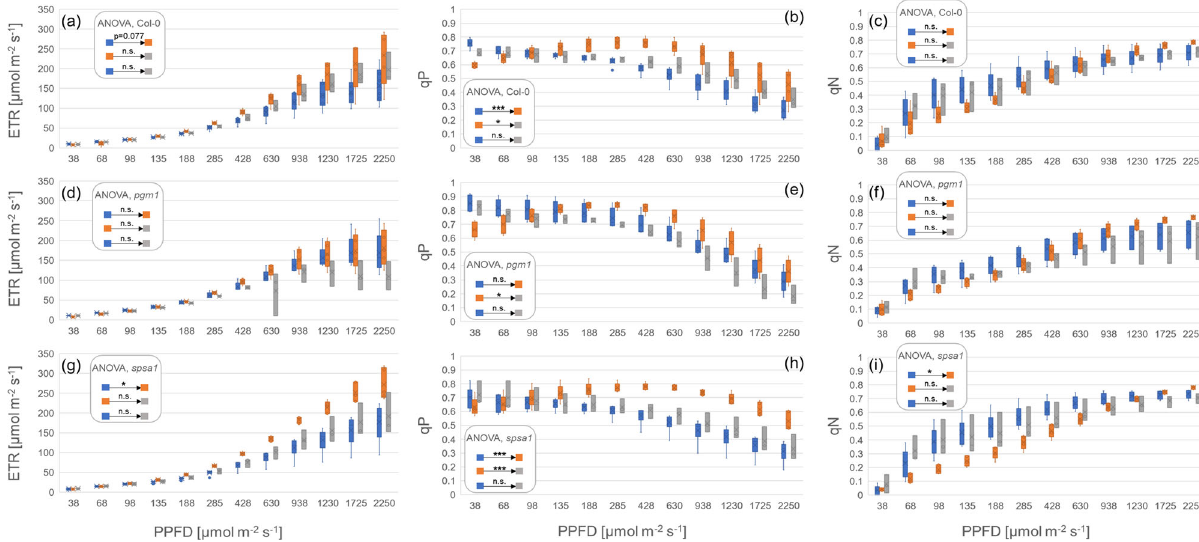
Fig. 4 Electron transport rates and quenching parameters under transient heat. Electron transport rates (ETR), photochemical (qP), and non- photochemical (qN) quenching were recorded within a rapid light curve (RLC) protocol. Blue: at 22 °C during the fi rst 2 h of the light phase. Left panel: ETR; middle panel: qP; right panel: qN. Orange: during exposure to 40 °C. Gray: after 2 h recovery at 22 °C. a – c Col-0, ( d – f ) pgm1 , ( g – i ) spsa1 . Box-and-whisker plots: center line, median; box limits, upper and lower quartiles; whiskers, 1.5× interquartile range; points, outliers. n = 3 – 6. Signi fi cances, revealed by ANOVA, are summarized in boxes; n.s.: not signi fi cantly different ( P > 0.05); * P < 0.05; *** P < 0.001. Experimental data are provided in Supplementary Data 3.